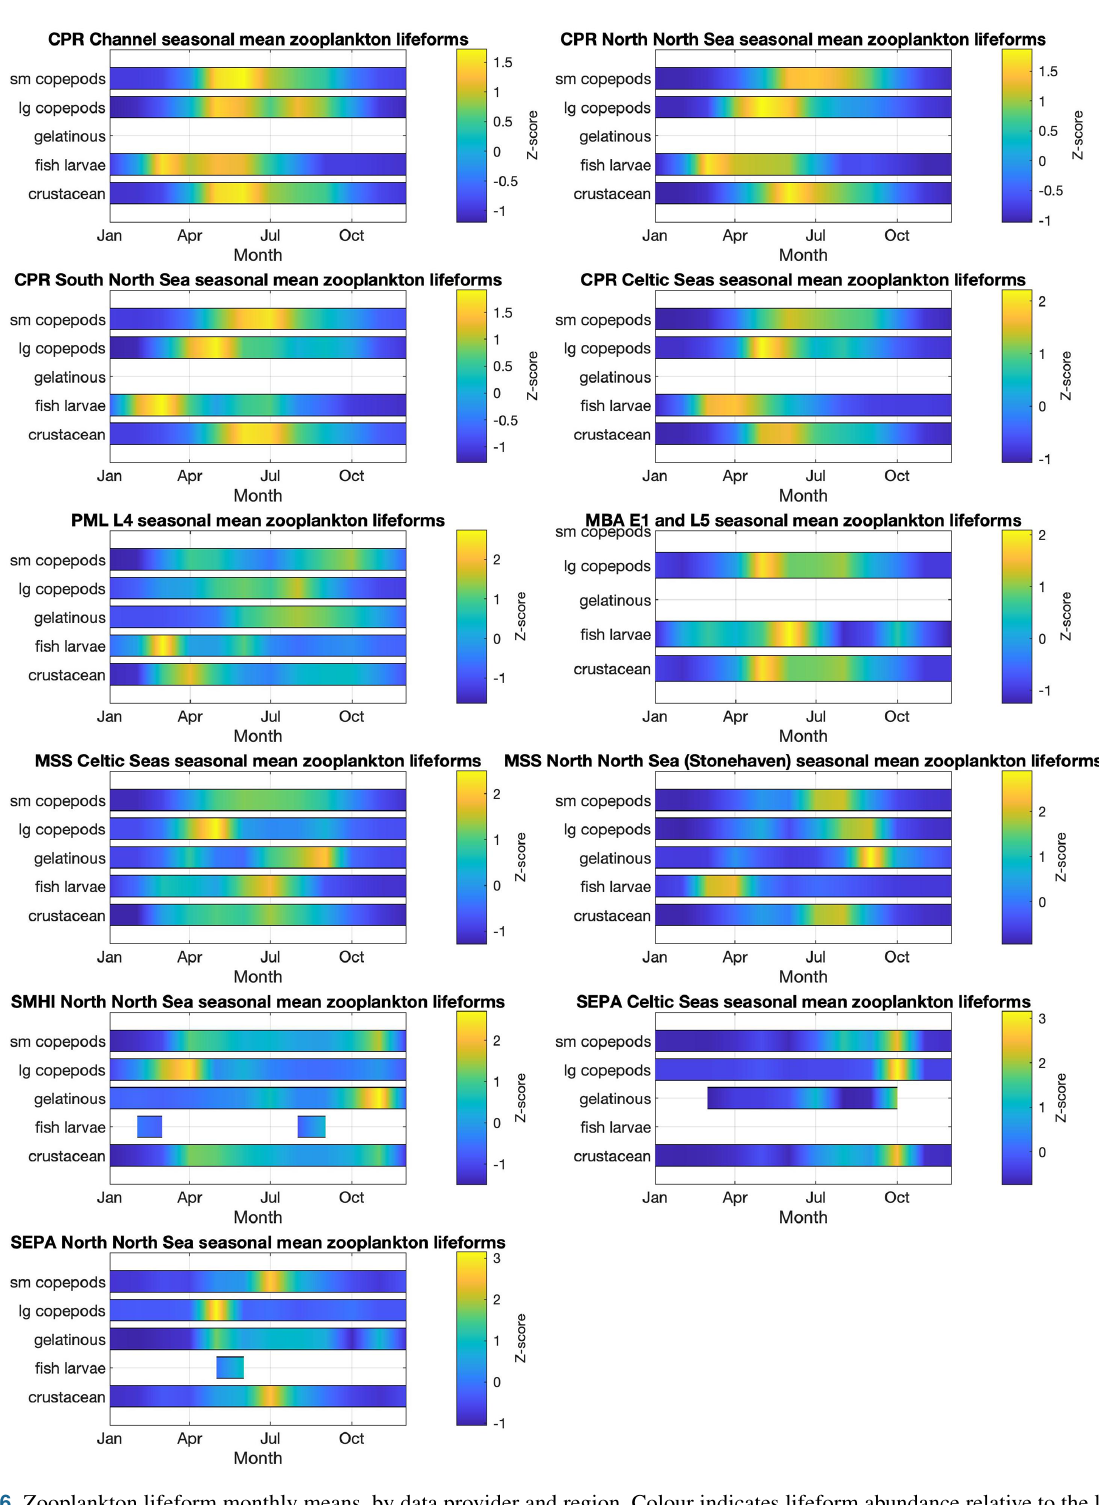
Figure 6. Zooplankton lifeform monthly means, by data provider and region. Colour indicates lifeform abundance relative to the long-term mean of each lifeform within each region and dataset as standardized z score Glover et al., 2005): scores of zero are equal to the long-term mean, positive scores (in green/yellow) signify values above the long-term mean, and negative scores signify values below the long-term mean (in blue). Only those lifeforms that have been assigned a confidence level of “high” are shown (see Tables 2 and 3). Regions are defined in Fig.